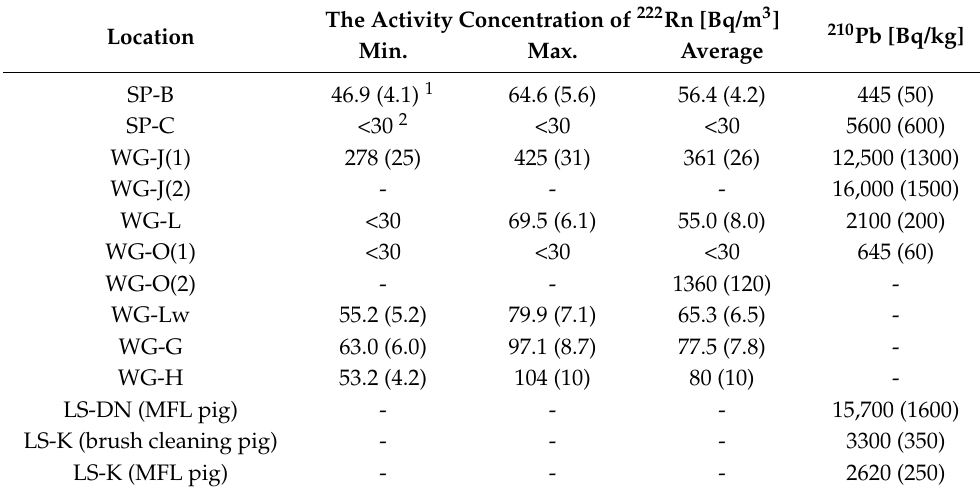
Table 2. The 222 Rn activity concentration in natural gas and the 210 Pb activity concentration in black